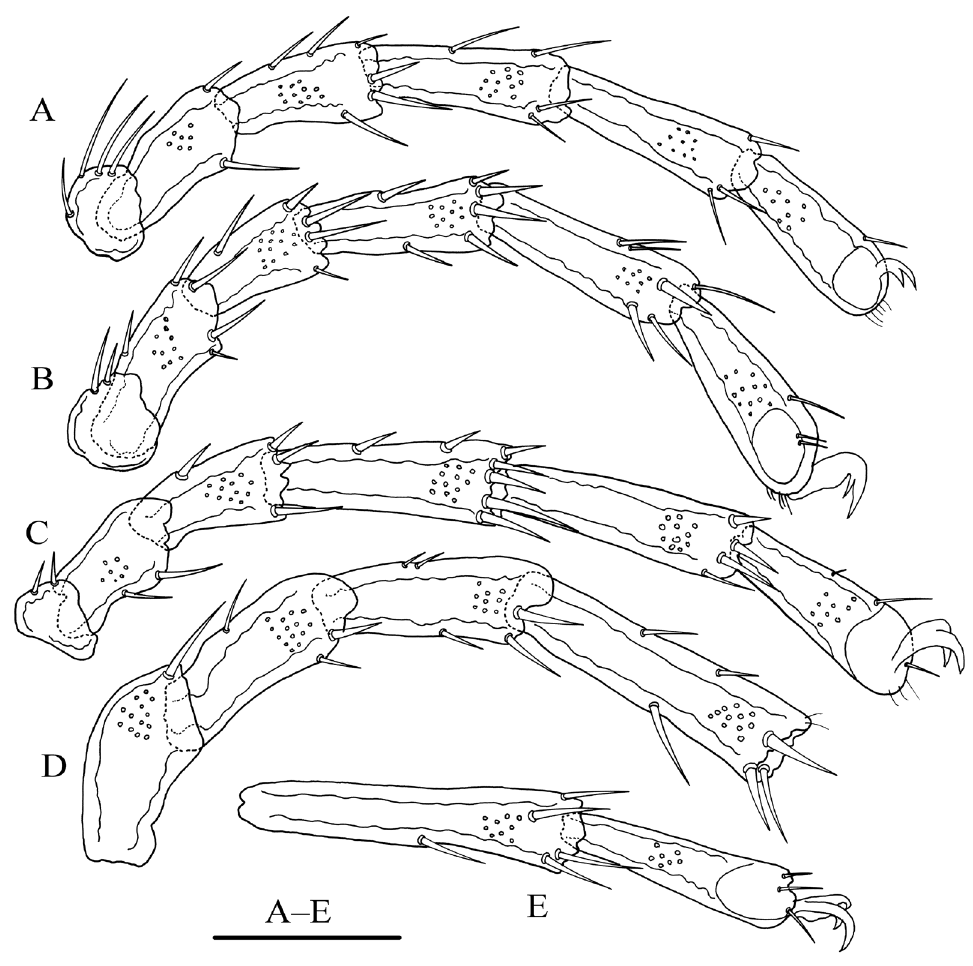
Fig. 12. Torrenticola wuyiensis Gu & Guo sp. nov., ♀, paratype (FJ-TO-20180812). A . leg-I. B . leg-II. C . leg-III. D . leg-IV-1–4. E . leg-IV-5–6. Scale bar = 100